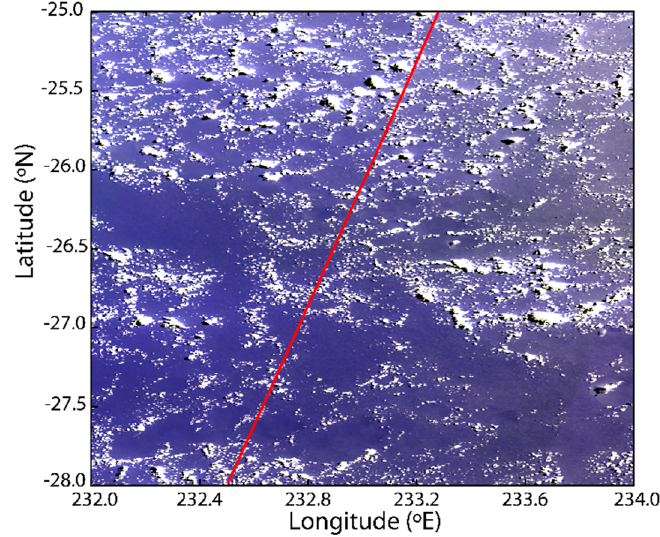
Figure 14. Sentinel-3A OLCI image dated 18 March 2018 from relative orbit 098 of cycle 029 showing no roughness distinct signatures along the altimeter satellite track (red line).